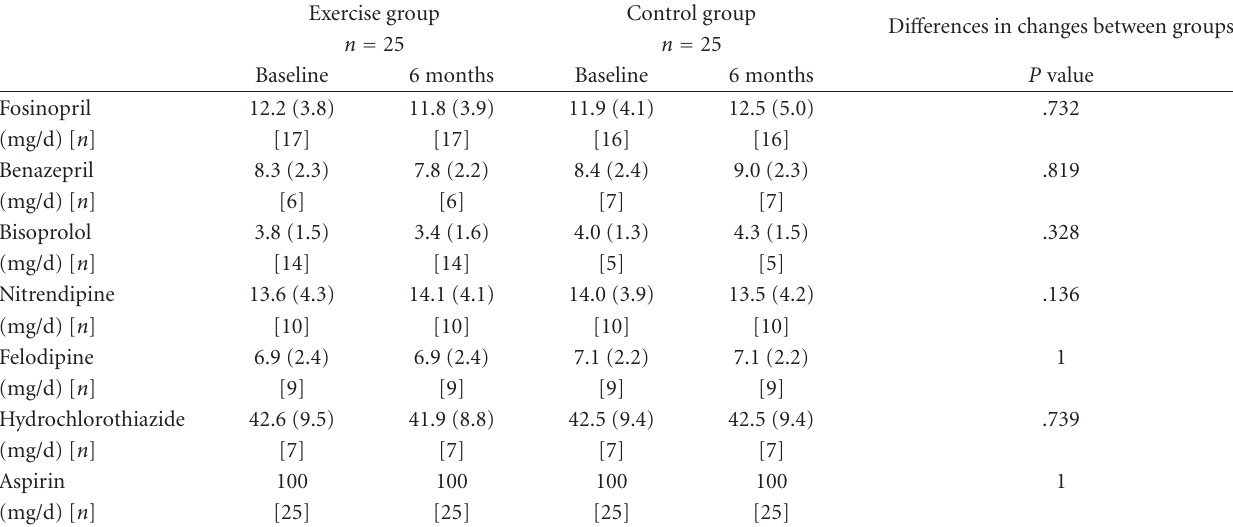
Table 2: Pharmacological therapy at baseline and after 6 months in the 2 patient